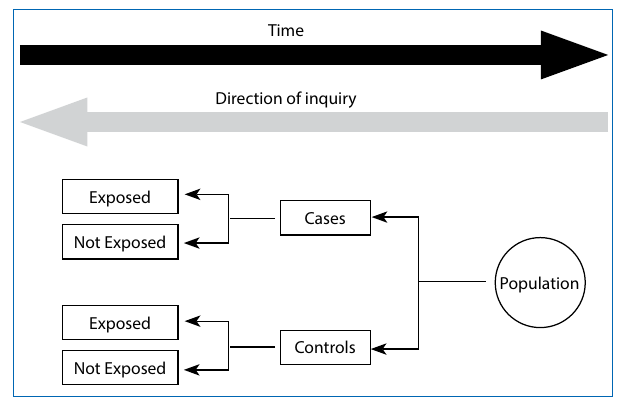
Figure 1: A Case-Control